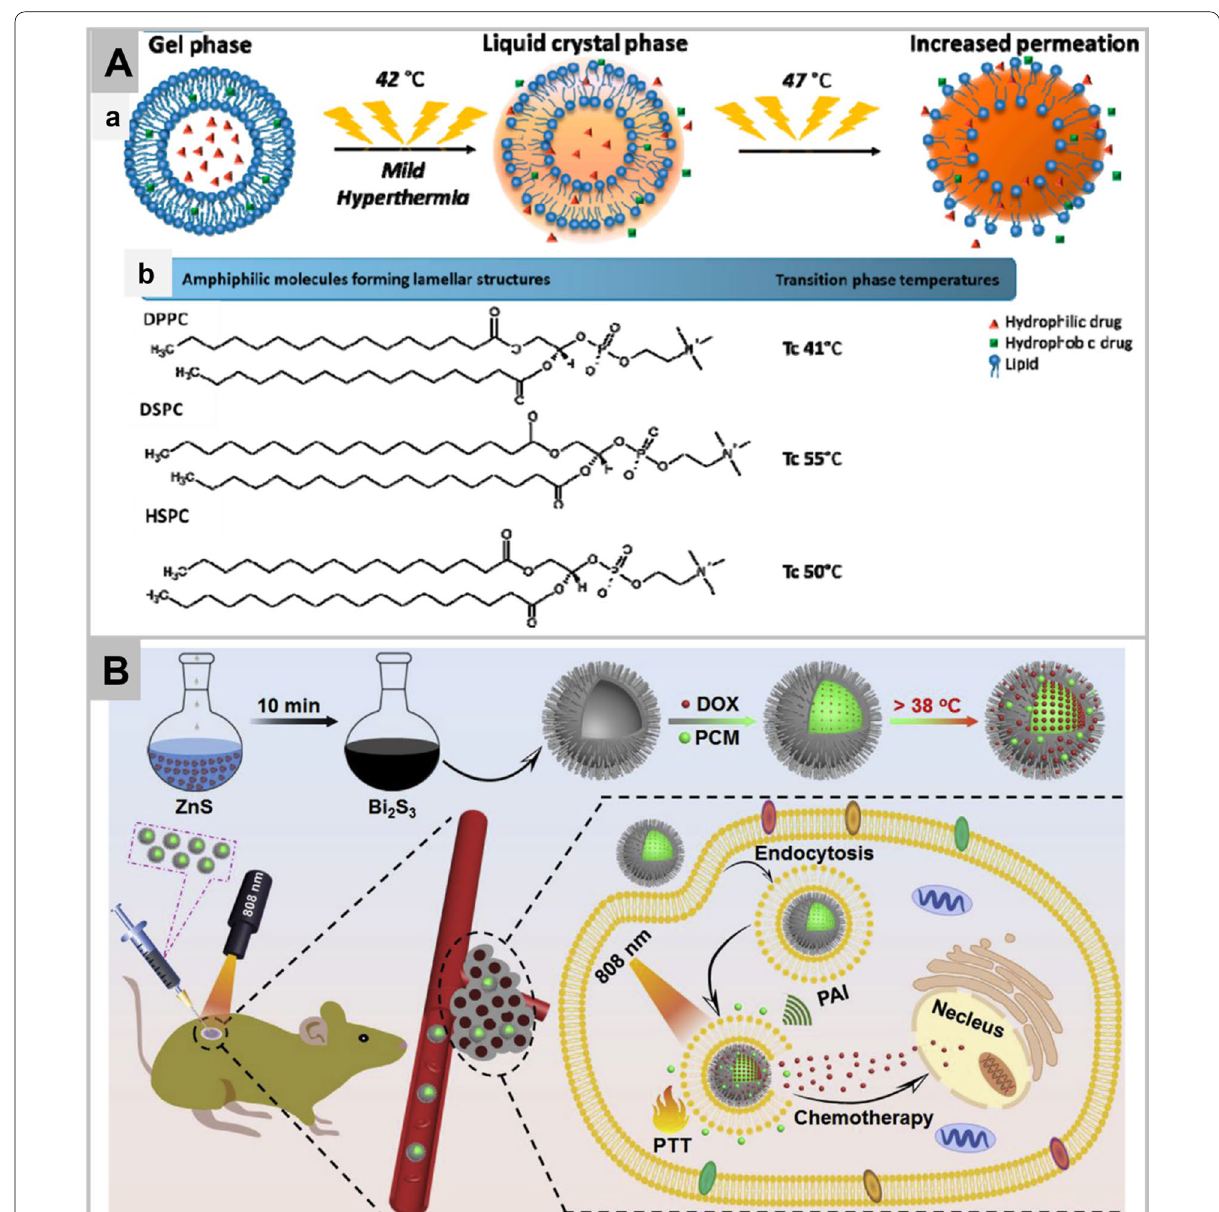
Fig. 5 Mechanism of drug release from thermosensitive liposomes. a Schematic illustration of the mechanism of phase transition of the lipids that form the liposome bilayer. The increase of the temperature above the transition phase temperature (47 °C) leads to higher bilayer permeability, and consequently, the drug release is favored. b Amphiphilic molecules forming lamellar structures and their transition phase temperatures. Tc: Phase transition temperature (Panel A ) [139]. A representation of the usage of hallow nanomaterials conjugated with phase changing materials for photolytic release of doxorubicin. The photothermal agent (Bi 2 S 3 nanomaterials) were synthesized using the polyol route displaying a photoconversion efficiency of 26.8%. The photothermal agent was encapsulated with doxorubicin and encoated with 1-tetradecanol acting as a gatekeeper until melting temperature of 38 °C was attained for the photothermal responsive drug release to be activated. (Panel B ). Reprinted